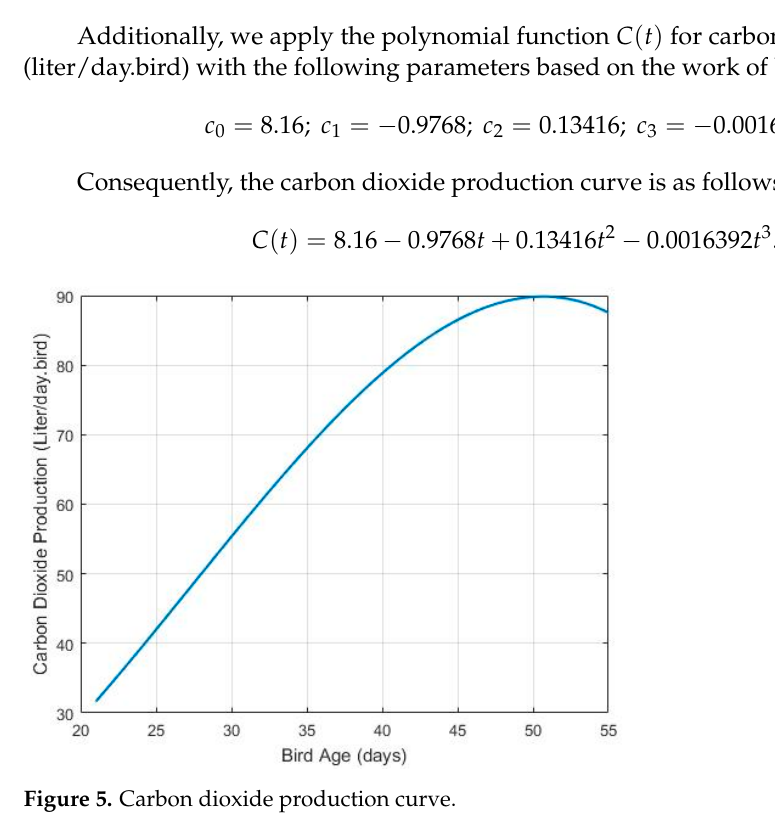
Figure 4. Cumulative daily mortality curve.